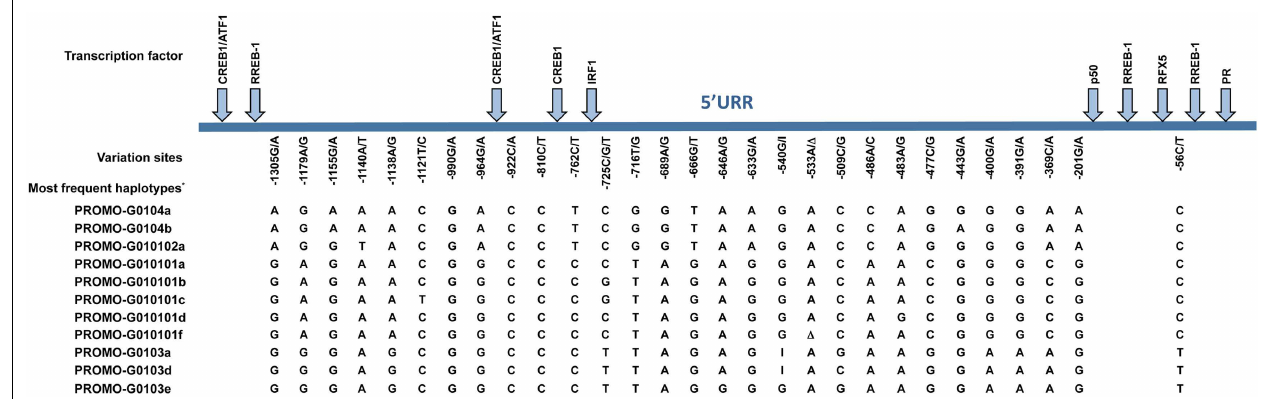
factors: CREB1, CAMP responsive element binding protein 1; ATF1, cyclic AMP-dependent transcription factor ATF-1; RREB1, Ras responsive element binding protein 1; IRF1, interferon regulatory factor 1; p50, nuclear factor NF- κ -B p105 subunit; RFX5, DNA-binding protein RFX5 (RFX